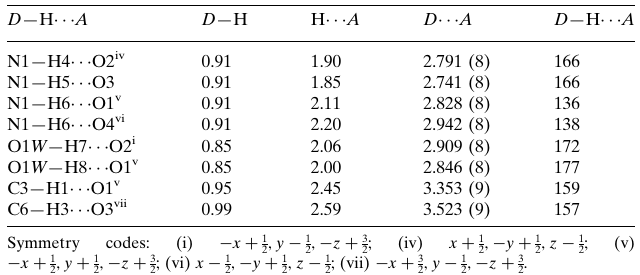
Hydrogen-bond geometry (A˚ , (cid:2)